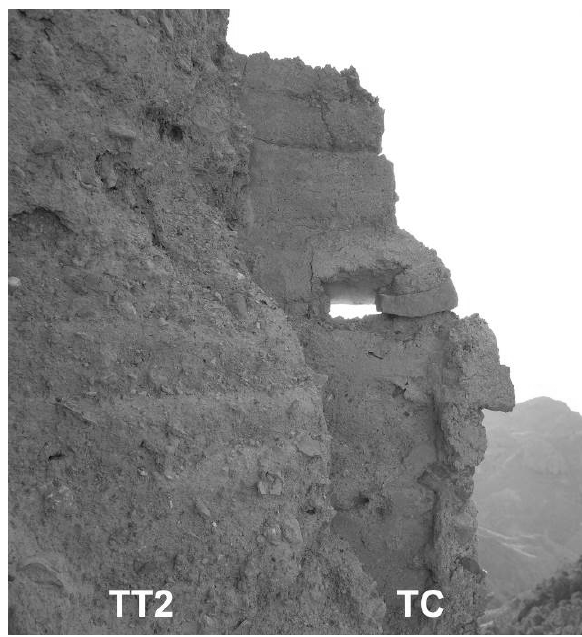
Figure 13. Tower I. Angle of (TT2) and (TC).